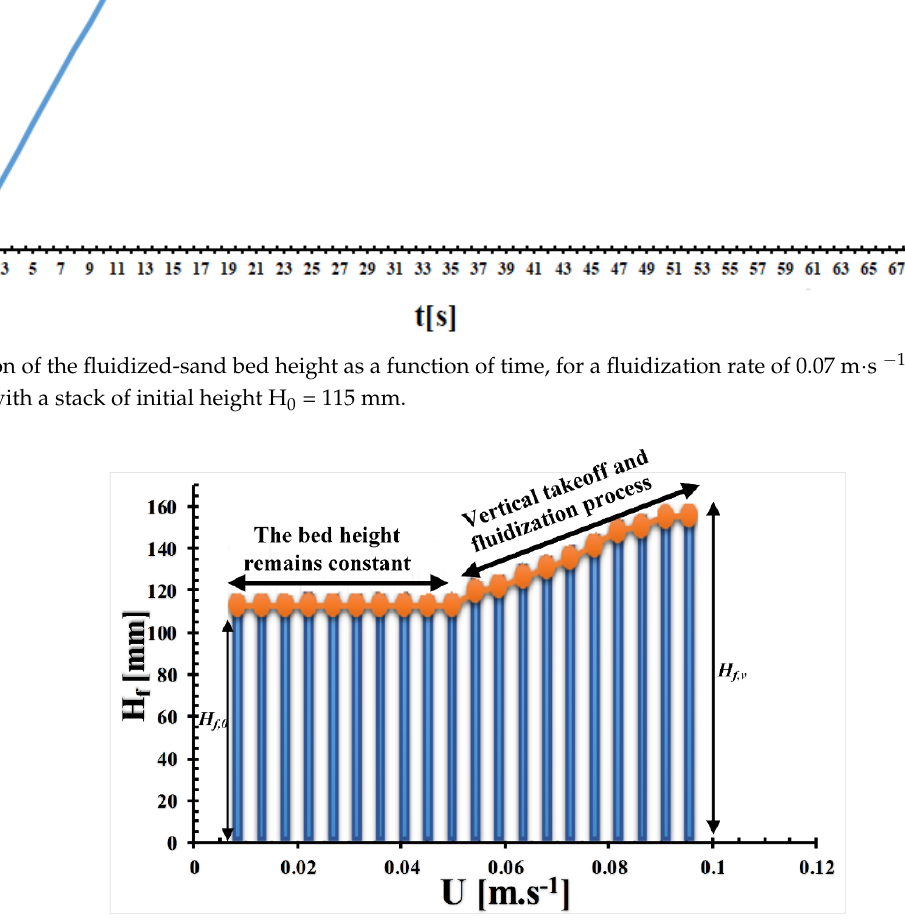
f as a function of the fluidization rate